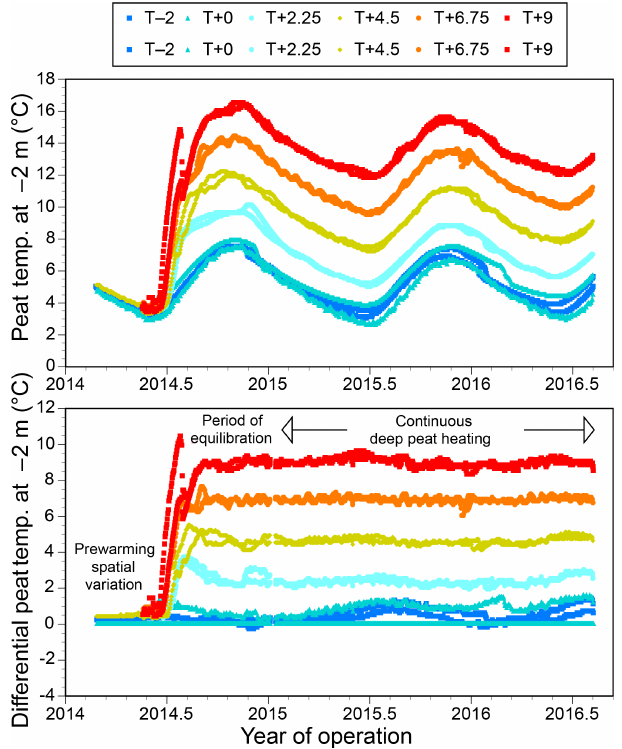
Figure 3. Daily mean deep peat temperatures (upper graph) and the associated temperature differentials (lower graph) at − 2m by treatment plots since 2014 including the initial warm up periods (June through early September 2014), and the sustained application of deep peat heating with air warming (beginning September 2014). Differential temperatures are referenced to sensors within the fully constructed but no-energy-added control plot 6. Unchambered am- bient plot data are also shown as T − 2